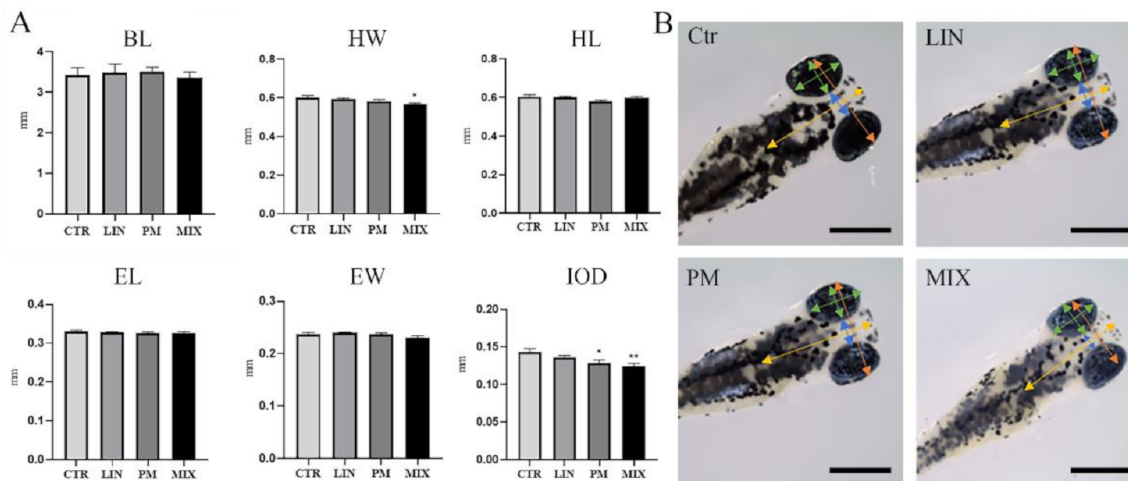
Figure 1. Morphometric measures of zebrafish larvae exposed to LIN and PM as single pesticides (LIN, PM) and mixtures (MIX) for 96 hpf ( n = 50/condition). ( A ) The morphological traits measured were body length (BL), head width (HW), head length (HL), eye length (EL), eye width (EW), interocular distance (IOD). All measures are expressed in millimeters. The results are expressed as mean ± SEM. * p < 0.05, ** p < 0.005 vs. Ctr. ( B ) Representative pictures of zebrafish larvae for each condition and description of morphological traits measured (scale bar: 0.3 mm).